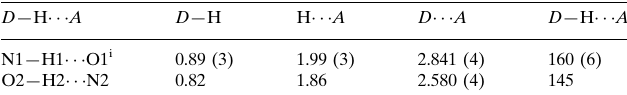
Hydrogen-bond geometry (A˚ , (cid:1)